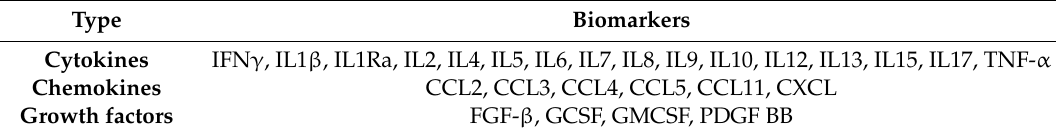
Table 2. List of serum inflammatory biomarkers to be assayed by multiplex immunoassay.